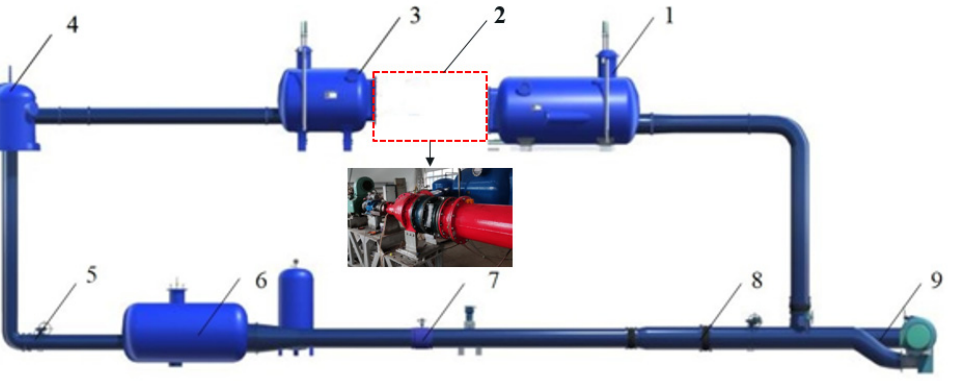
Figure 5. Physical schematics of the test bench. The main measuring instruments of the test system include differential pressure pressure transmitter. and so on. Table 1 shows the specific parameters of the main rameters of pressure sensor in pressure pulsation test. The specific parameters of the pressure sensor in the pressure pulsation test are shown in Table 2. The sampling fre- quency of the pressure pulsation sensor is 124 times that of the impeller rotation fre- quency (RF), which can meet the requirements of the pressure pulsation acquisition in the axial flow pump system [31]. The pressure pulsation experiment uses synchronous channel record, monitoring points p1, p2, and p3 pressure pulsation signal acquisition is synchronous. Figure 6 shows the schematic layout of pressure pulsation measuring points. Three pressure fluctuation monitoring points are located near the impeller inlet, the impeller middle, and near the impeller outlet. Table 1. Main measuring instruments for energy characteristic experiment.